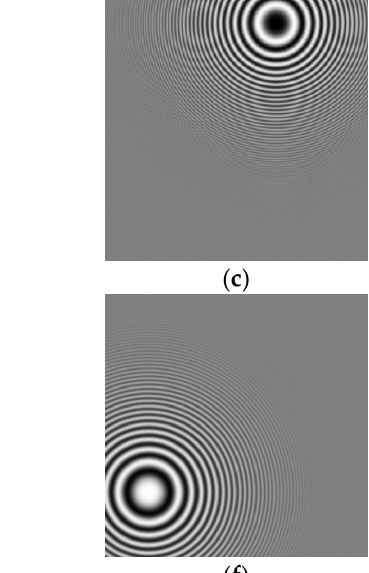
Figure 7. The separated and reconstructed fringe patterns ( a – f ) from the mixture signal shown in Figure 3a.